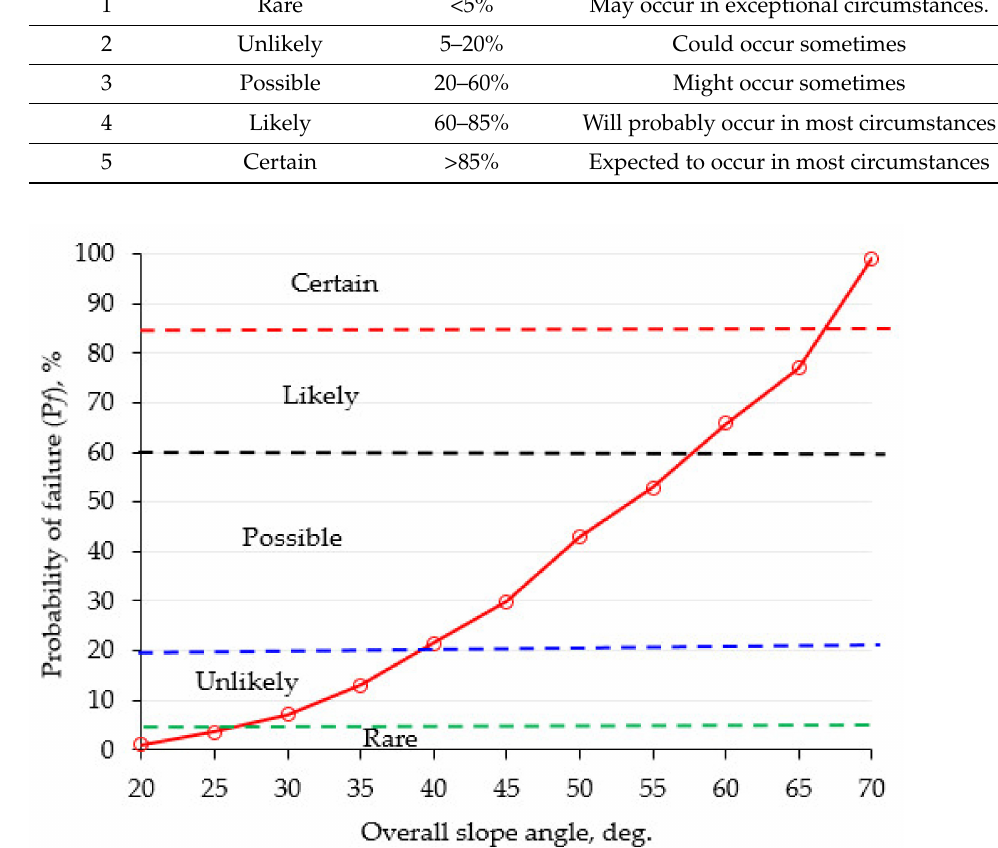
Figure 11. Probability of failure, P f , at various slope angles based on factor of safety (e.g., at FOS threshold = 1.5).